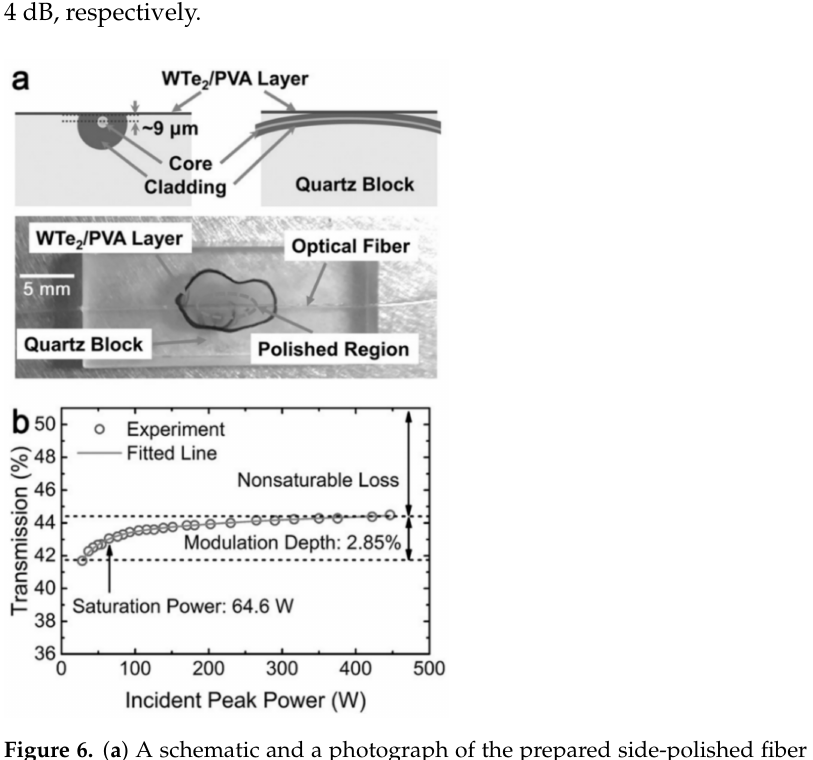
Figure 6. ( a ) A schematic and a photograph of the prepared side-polished fiber deposited with a WTe 2 -PVA composite film. ( b ) Measured nonlinear saturable absorption curve of the side-polished fiber deposited with a WTe 2 -PVA composite film. Reprinted with permission from